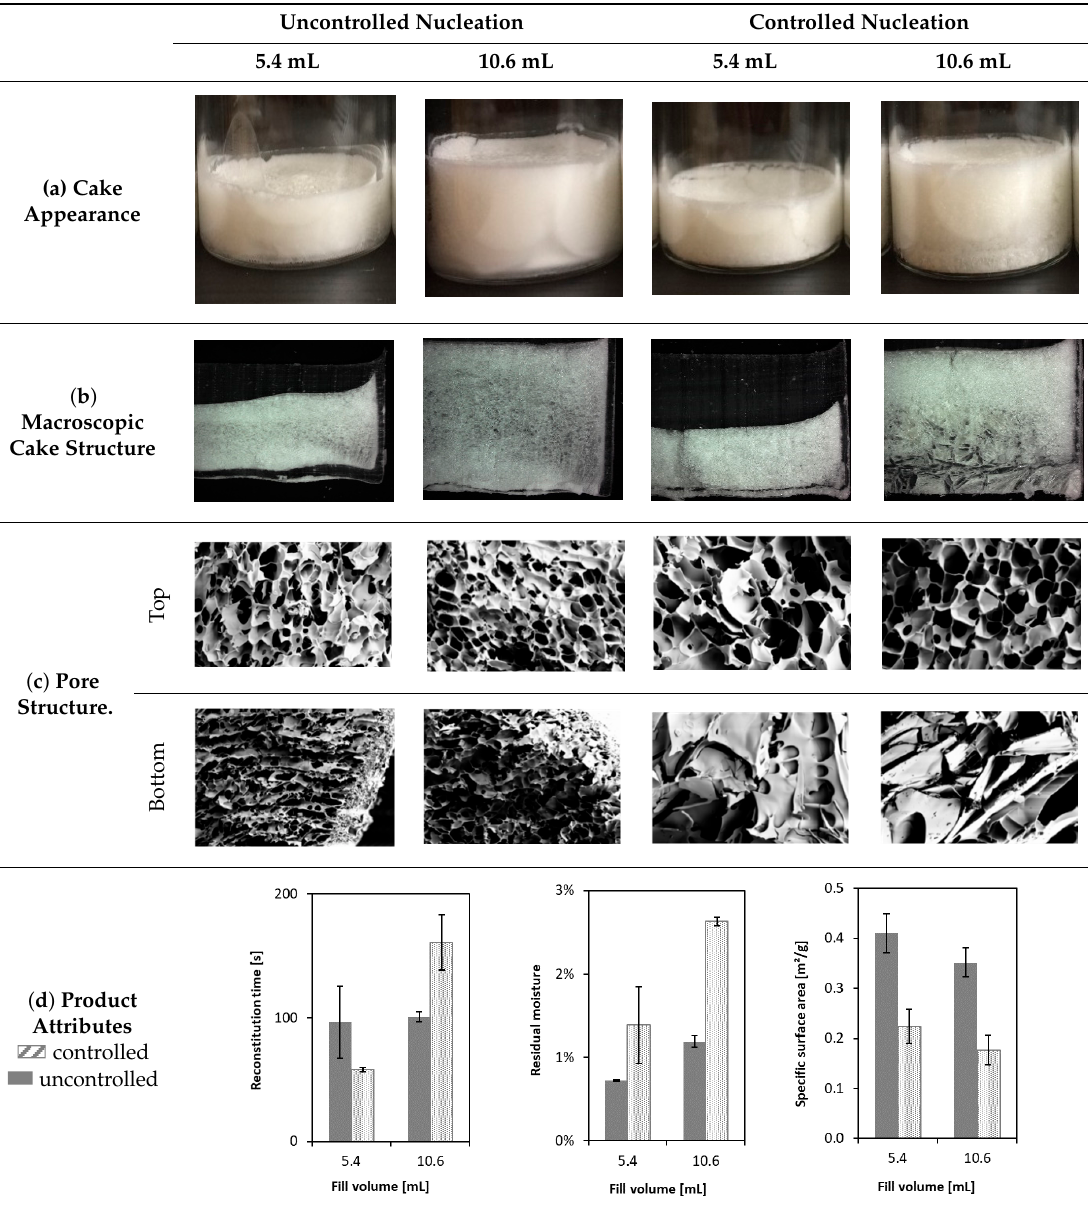
Table 2. Comparison of product attributes of uncontrolled versus controlled nucleated bovine serum albumin (BSA) formulations at 5.4 and 10.6 mL fill heights in 20 cc vials. (a) Cake appearance by visual inspection, (b) macroscopic cake structure by polydimethylsiloxane (PDMS) embedding, (c) pore structure by SEM, and (d) reconstitution time (n = 3), residual moisture (n = 2), and specific surface area (n = 4). Average values of individual measurements (n) with standard deviation are presented.